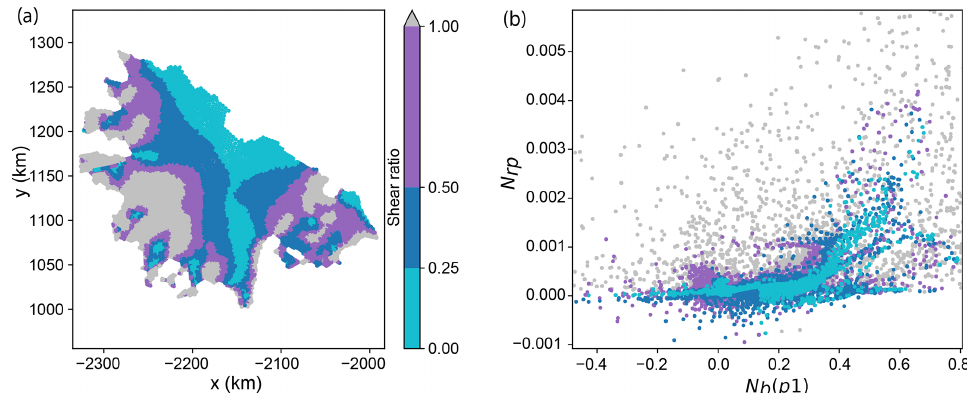
Figure 10. (a) Larsen C model domain colored by the shear metric, m s (Eq. 12). (b) Scatter plot of N b (p 1 ) and N rp colored by different values of m s